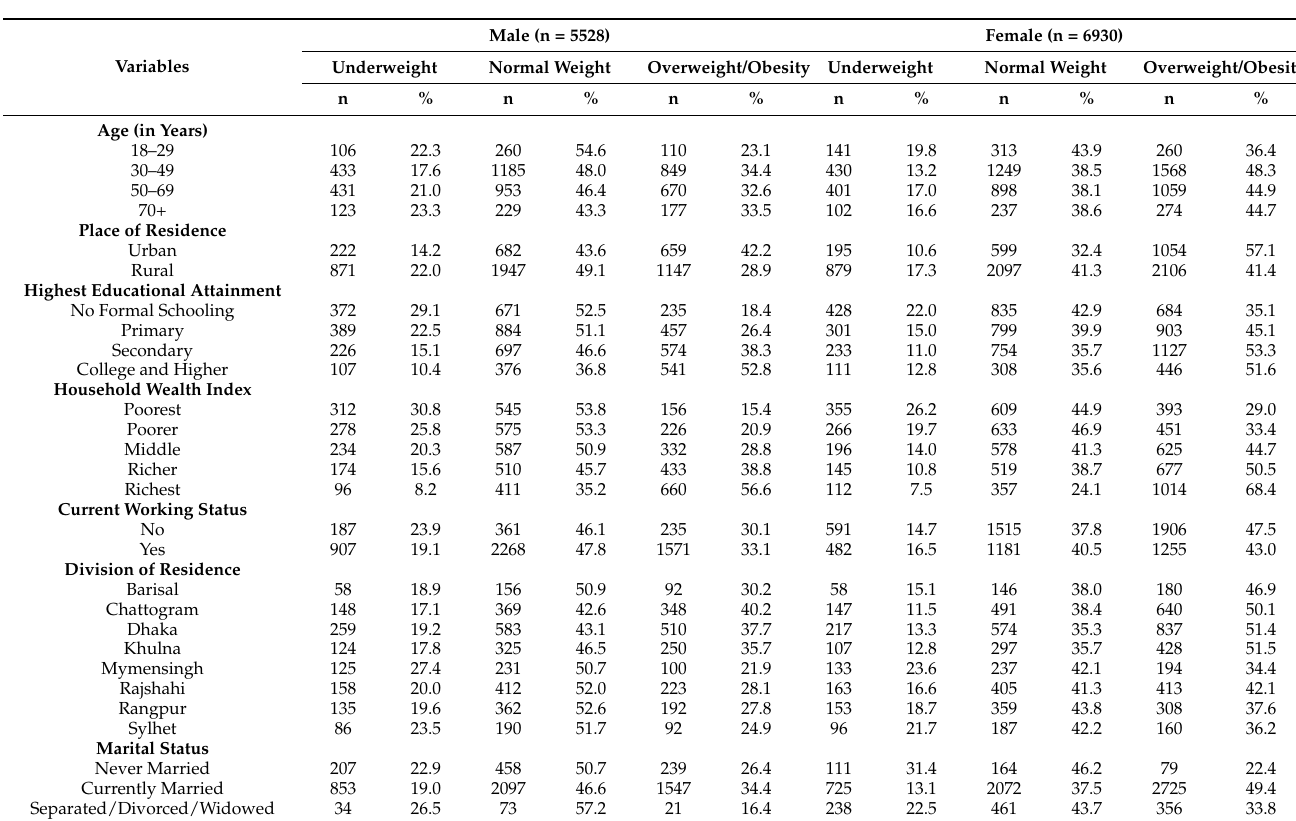
Table 1. Sample characteristics according to prevalence of different categories body mass index according to gender, BDHS